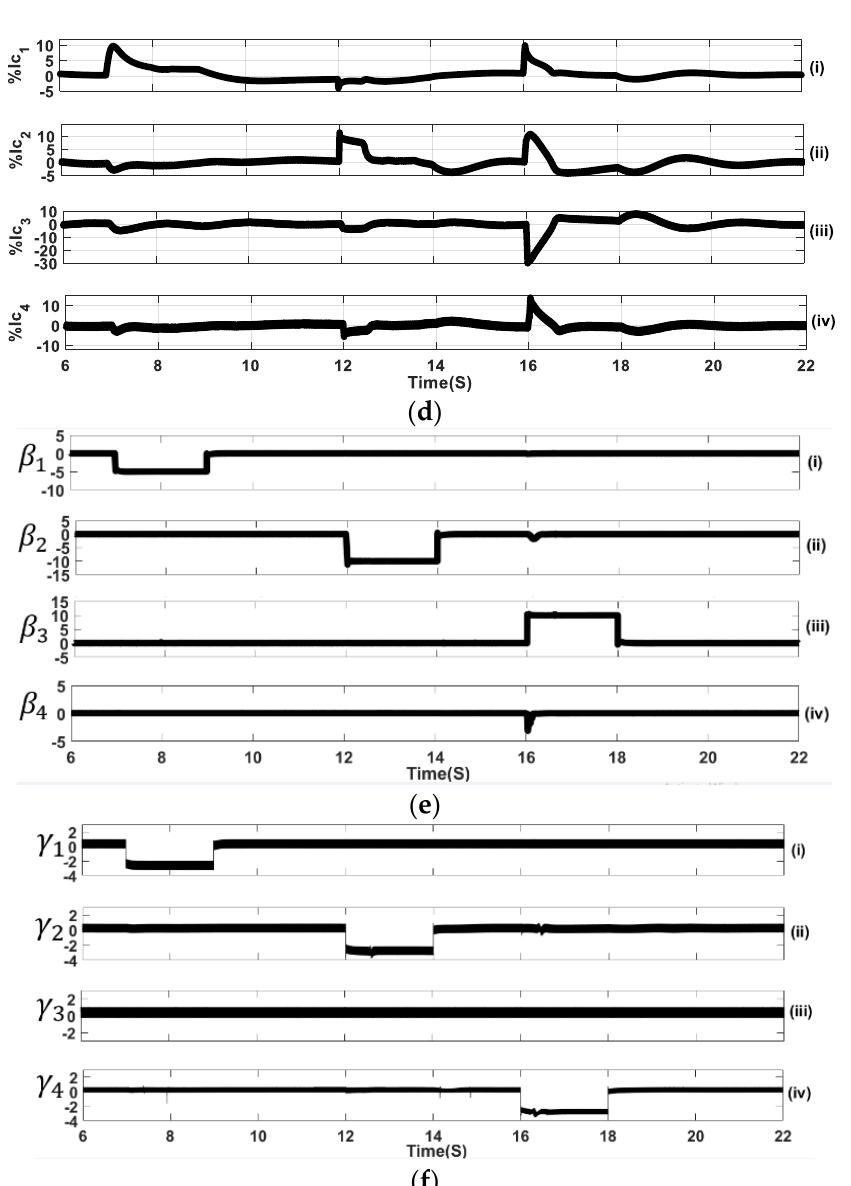
Figure 14. Fifth case study: ( a ) v i , ( b ) I out i , ( c ) % Ve i , ( d ) % Ic i , ( e ) voltage cyber-attack mitigation signals for DGUs, β i , and ( f ) current cyber-attack mitigation signals for DGUs, γ i .